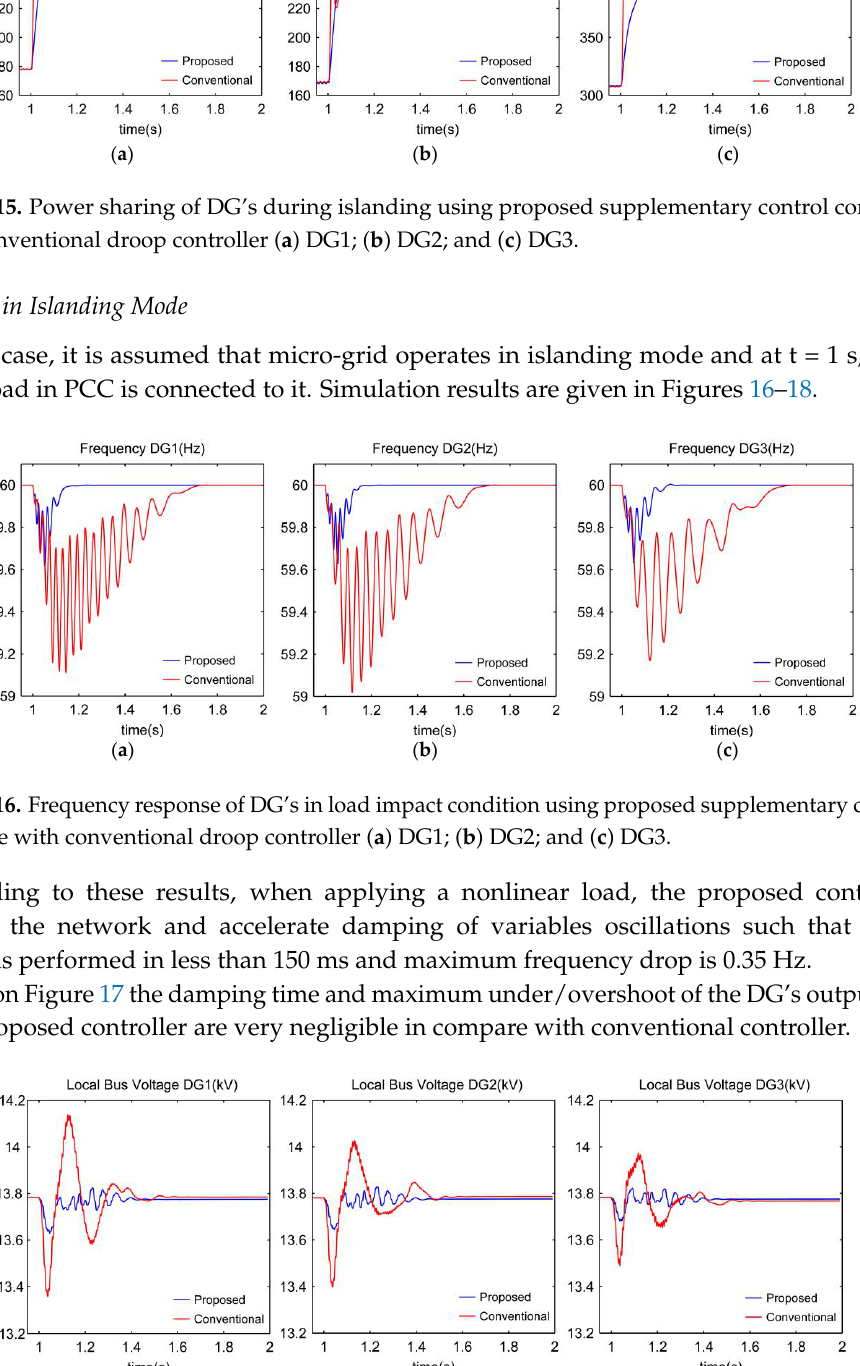
Figure 14. Voltage response of DG’s during islanding using proposed supplementary control